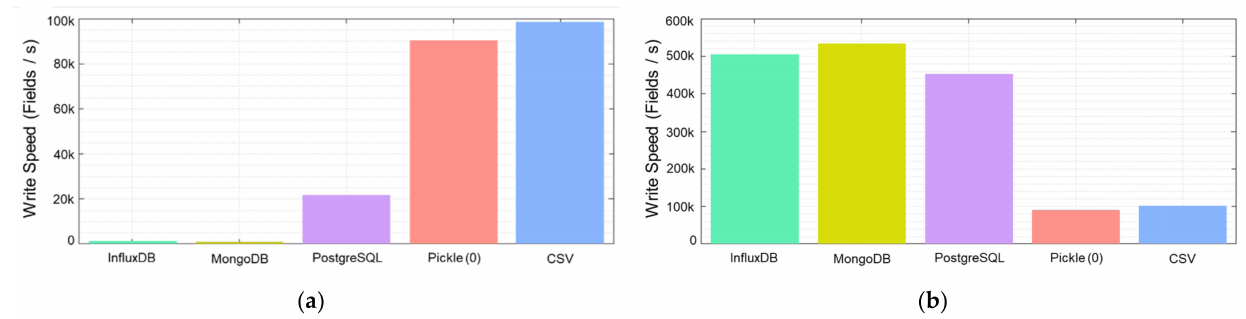
Figure 15. ( a ) Written fields per second for single field processing. ( b ) Written fields per second for accumulated batch